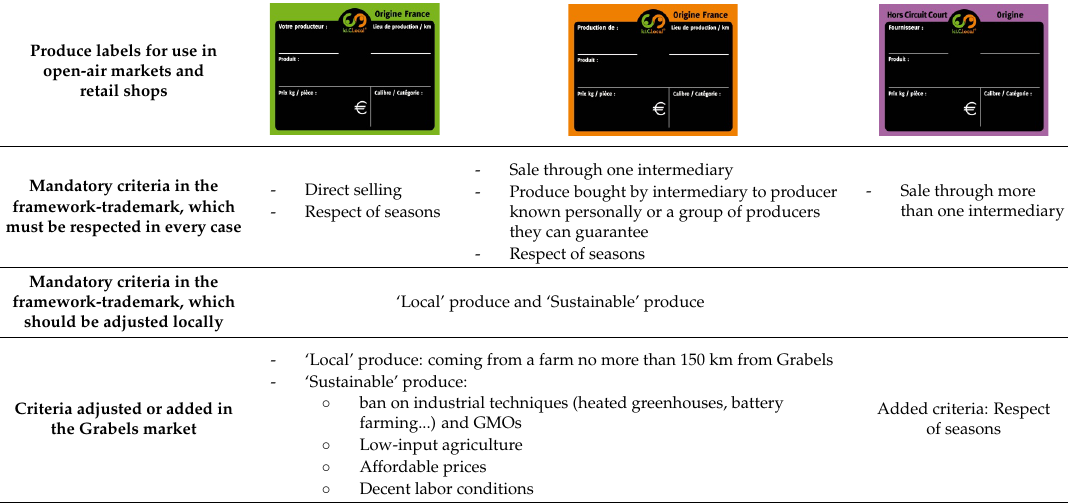
Table 1. Labelling system criteria for Ici.C.Local trademark, adjusted in the Grabels case. Produce labels for use in open-air markets and